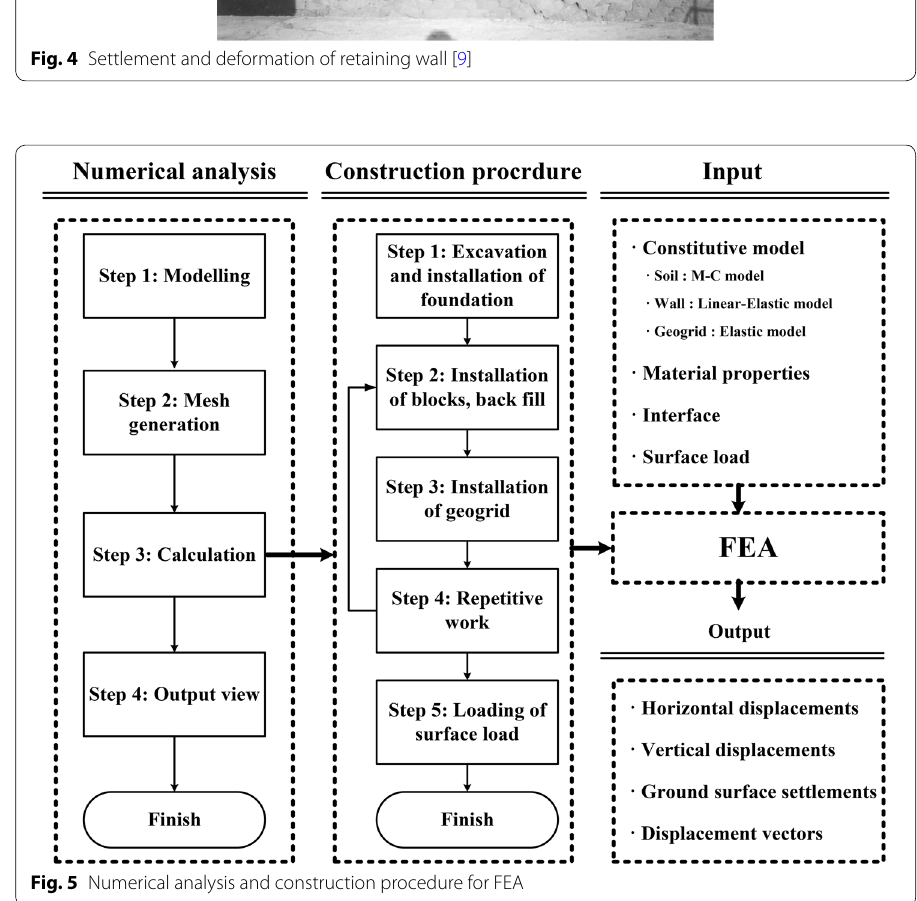
Fig. 5 Numerical analysis and construction procedure for